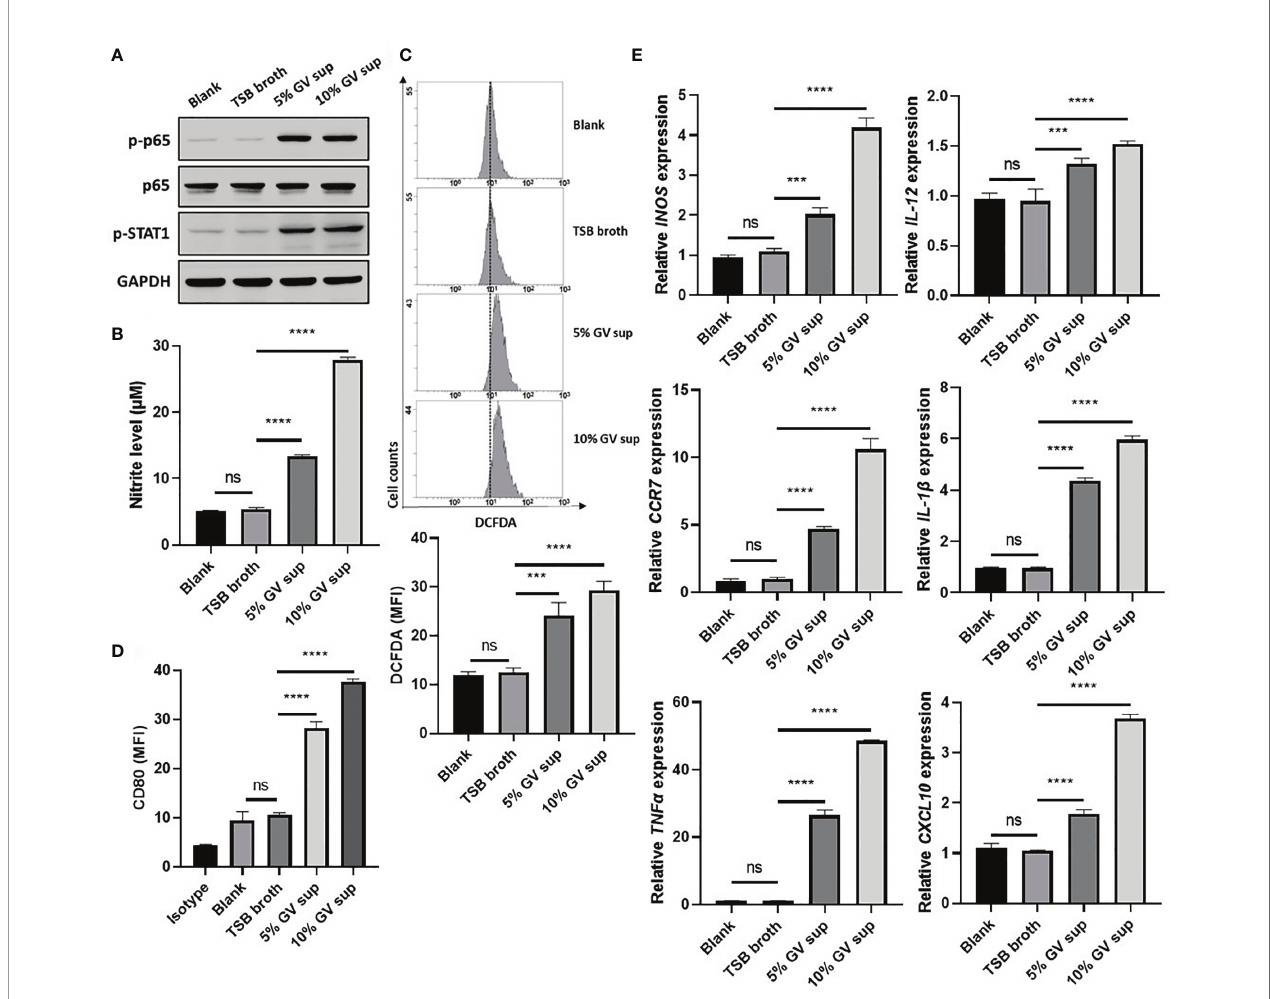
FIGURE 1 | G. vaginalis -free culture supernatants (GV sup) induce M1 phenotype in THP-1 macrophages. PMA (phorbol 12-myristate 13-acetate)-differentiated THP-1 cells were stimulated with control medium (Blank), TSB broth, 5% or 10% (v/v) GV sup for 24 h. (A) Detection of phosphorylated STAT1 (p-STAT1) and NF k B p65 subunit (p-p65) by immunoblotting. GAPDH was used as an internal control to show equal protein loading. (B) Nitric oxide (NO) produced by the cells was assayed after treatment. (C) The reactive oxygen species (ROS) production was measured by DCFDA assay using fl ow cytometry. The mean fl uorescence intensity (MFI) is shown in the bar graphs. (D) Macrophage surface marker (CD80) was detected by fl ow cytometry. The mean fl uorescence intensity (MFI) is shown. The black bar graph indicates isotype controls. (E) Gene expression levels of M1 macrophage markers ( INOS, IL-12, CCR7, CXCL10, TNF a , and IL-1 b ) were measured by qRT-PCR. Data were represented the normalized target gene amount relative to the blank group. Data are presented as mean ± SD of three independent experiments (*** P < 0.001; **** P < 0.0001; ns, not statistically signi fi